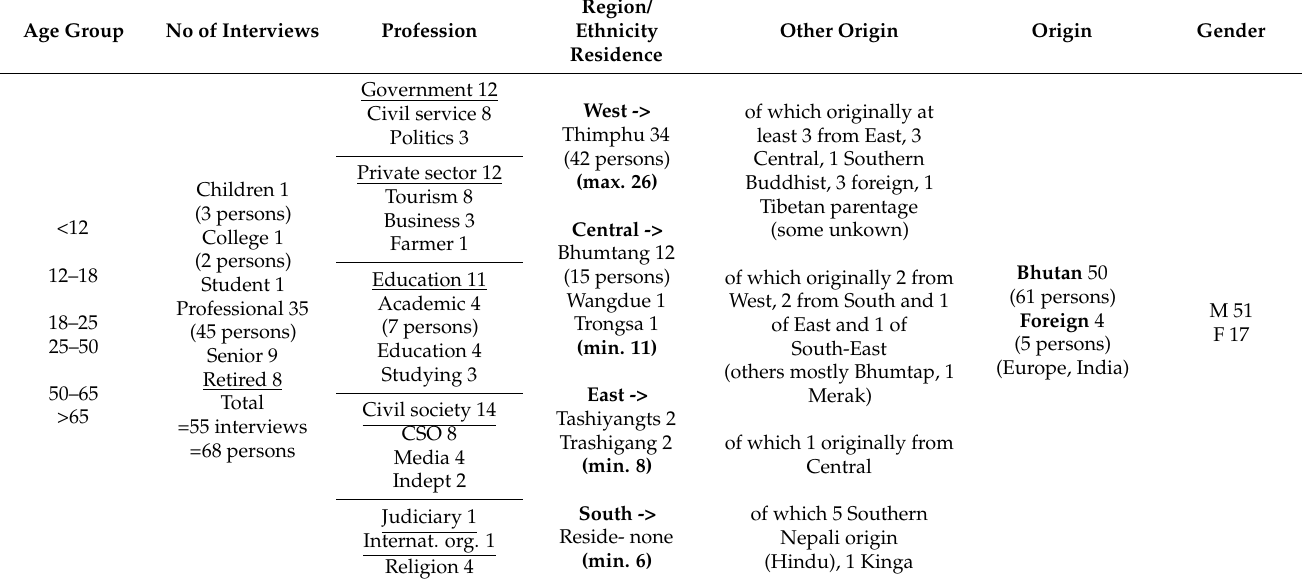
Table 1. Breakdown of interviews in